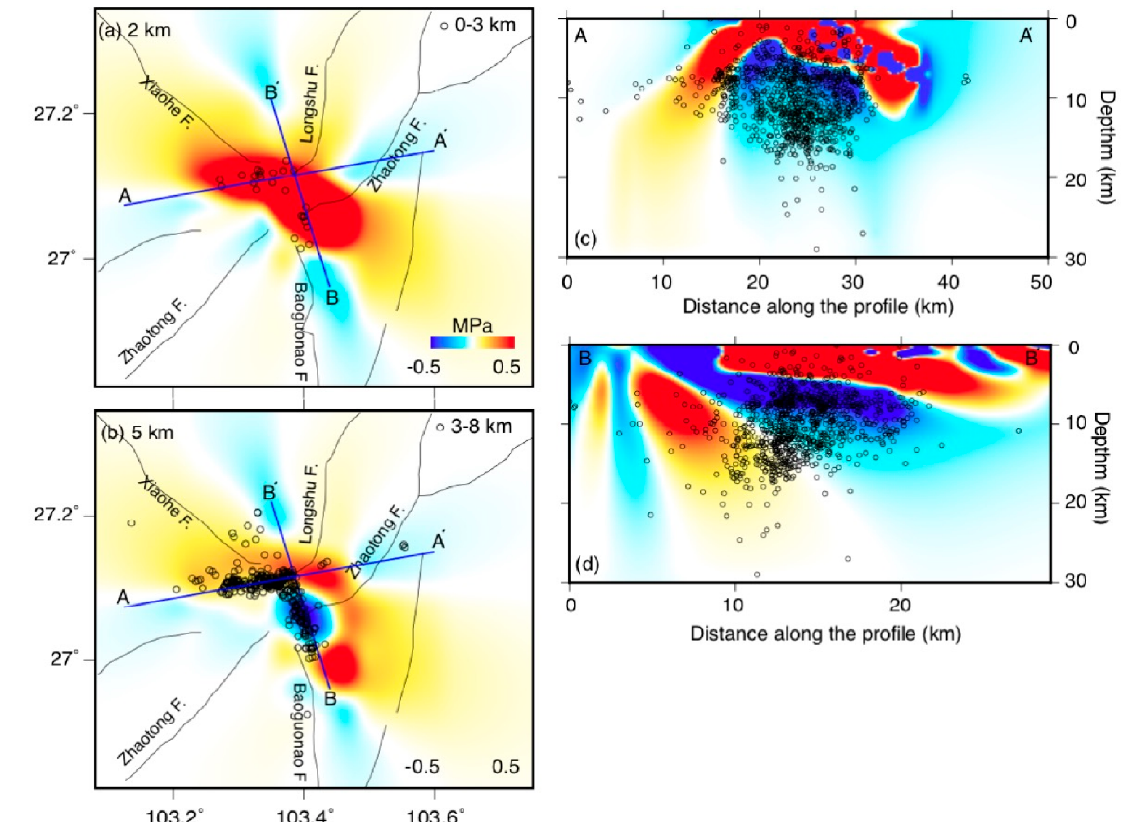
Figure 7. Coulomb failure stress changes on optimally oriented strike-slip faults at depths of ( a ) 2 km and ( b ) 5 km. ( c )–( d ) The coulomb failure stress changes along the profiles A-A ’ and B-B ’ shown in ( a ), respectively. The open black circles are the aftershocks. Note that the friction coefficient was chosen to be 0.4, and all the panels share the same color code.